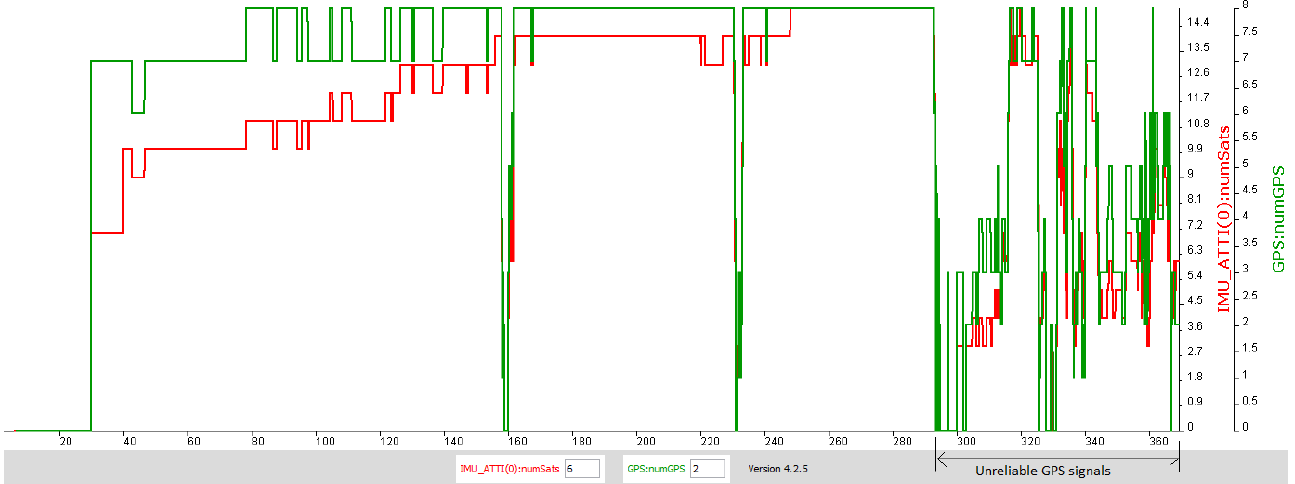
Figure 5. Unreliable GPS signal observed in the